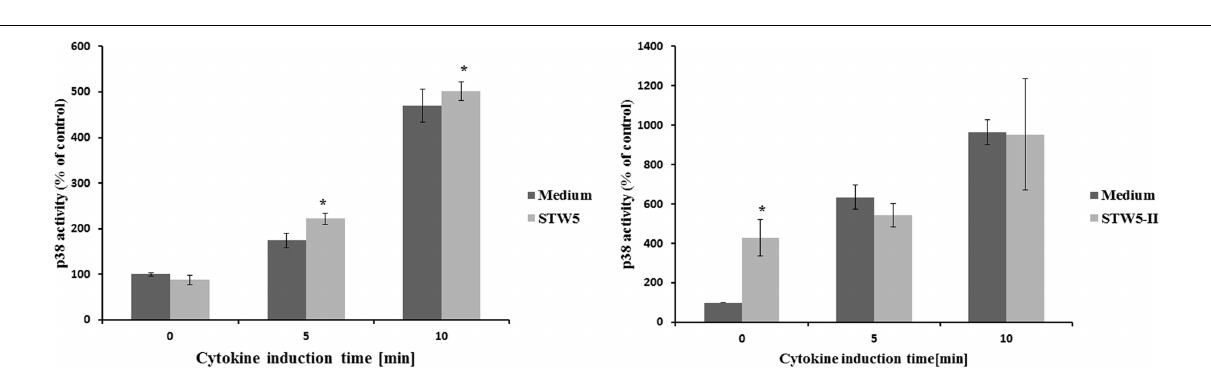
FIGURE 6 | Effects of STW5 and STW5-II on p38 activity NCM460 cells were treated with the CM (10 ng/ml TNF- α , 5 ng/ml IL-1 β , and 10 ng/ml IFN- γ ) for the indicated time points prior to harvesting and p38 activity measurement by ATF-2 phosphorylation. The upper panel shows a representative western blot for pATF-2. The lower panel displays the quantification of three independent western blot experiments (pixel density fold change compared to 0 min; three independent experiments; ∗ denotes statistical significance at p < 0.05 vs. 0 min).